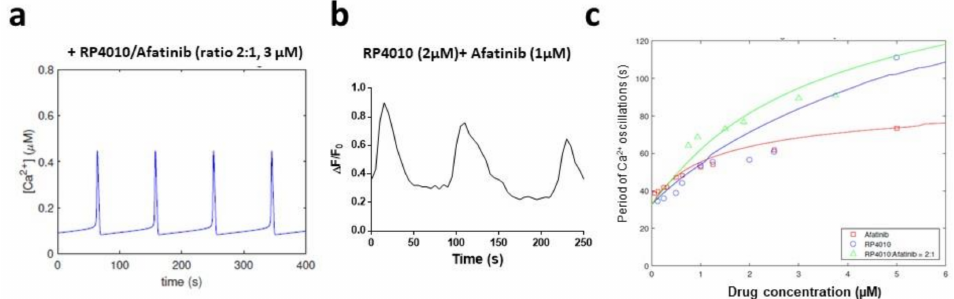
Figure 4. Effect of combined treatment of RP4010 and afatinib on intracellular Ca 2+ oscillations. ( a ) Mathematical simulation of Ca 2+ dynamics in KYSE-150 cells treated with combined RP4010 and afatinib (2:1 ration at 3.0 µ M). ( b ) A representative trace of intracellular Ca 2+ concentration measured by time-lapse live-cell imaging in KYSE150 cells treated with combined 2 µ M RP4010 and 1 µ M afatinib. ( c ) Dose-dependent curves of simulated periods of intracellular Ca 2+ oscillations in KYSE-150 cells treated with either RP4010 (blue), afatinib (red) or combination (green). Individual circle, square or triangle is from experimental